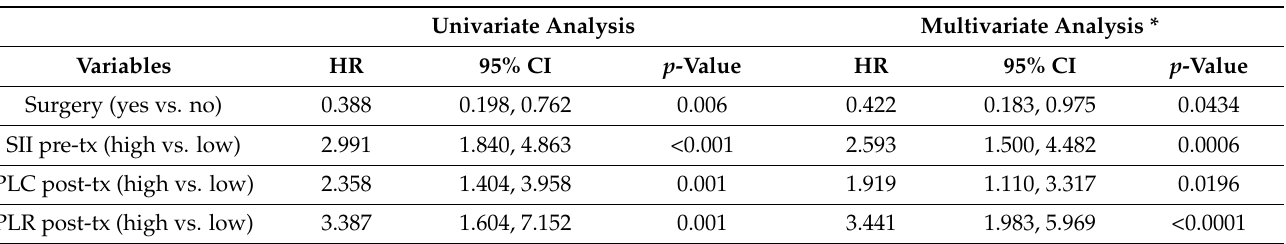
Table 6. Variables associated with disease free survival (DFS) when both pre- and post-treatment markers were included in the model.